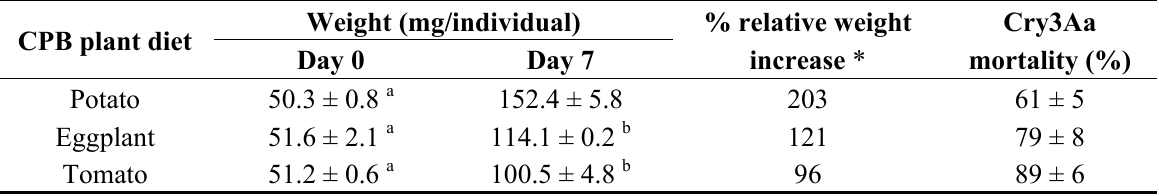
Table 1. Feeding performance of CPB larvae on three solanaceous plants and mortality caused by a 4.3 pmol Cry3Aa toxin dose. Data are the mean values ± SE of three replicates ( n = 3) of each sixteen larvae.